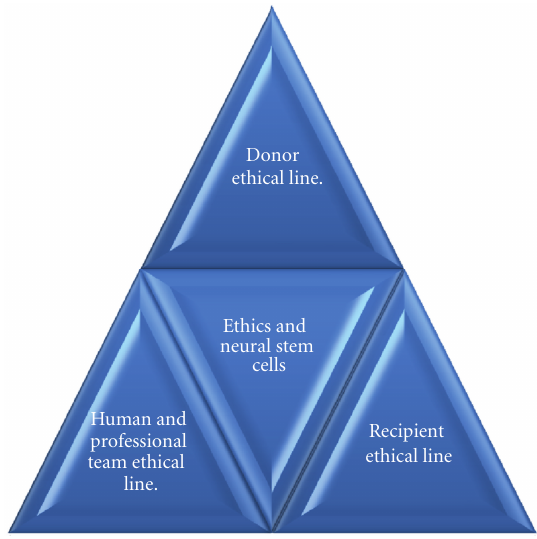
Figure 1: Bioethical triangle in the research and use of neural stem